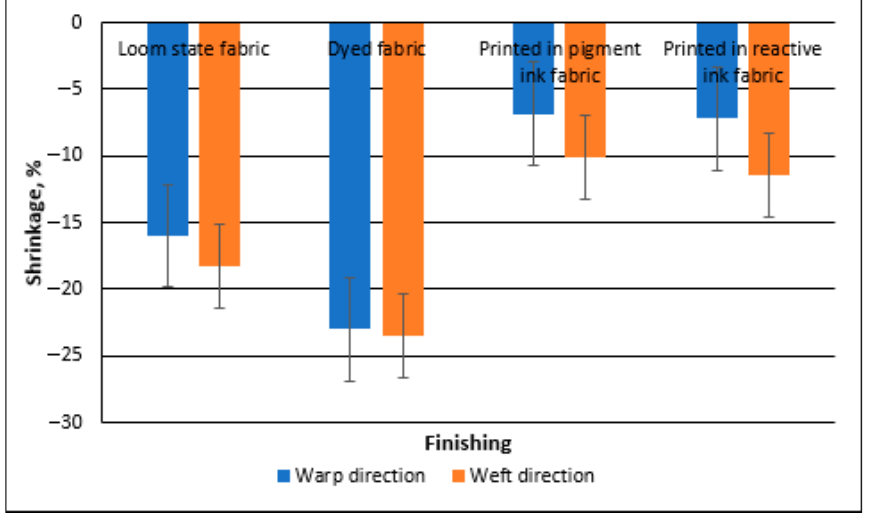
Figure 5. Percentage of shrinkage of fabrics in the directions of warp and weft after finishing.